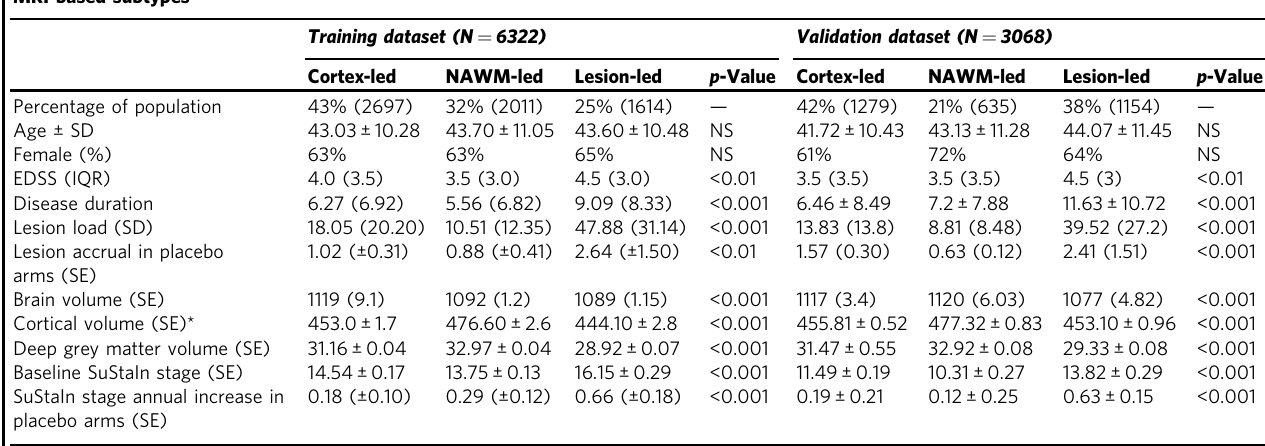
Table 3 Characteristics of MRI-based subtypes in the training and validation